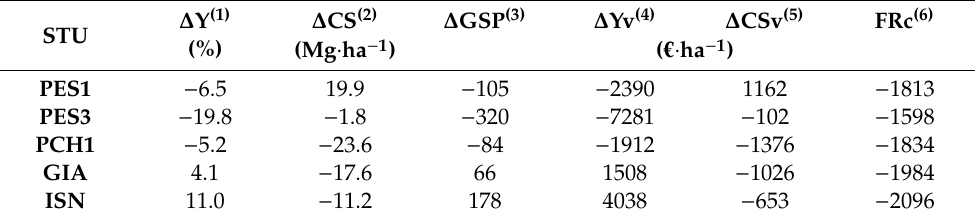
Table 4. Economic land evaluation based on STUs (PES1 and PES3: Peschiera1 and 3, PCH1: Porta Chiozza1; GIA: San Giacomo, ISN: Isolone units). (1) : mean yield variation from the local average, standardized for crop typology and year; (2) : variation of carbon stock (0–30 cm) from the local mean (50.35 Mg · ha − 1 ); (3) : variation from the local average of annual gross saleable production; (4) : variation of productive value of a land, calculated by eq. (3); (5) : variation of the land value due to di ff erent